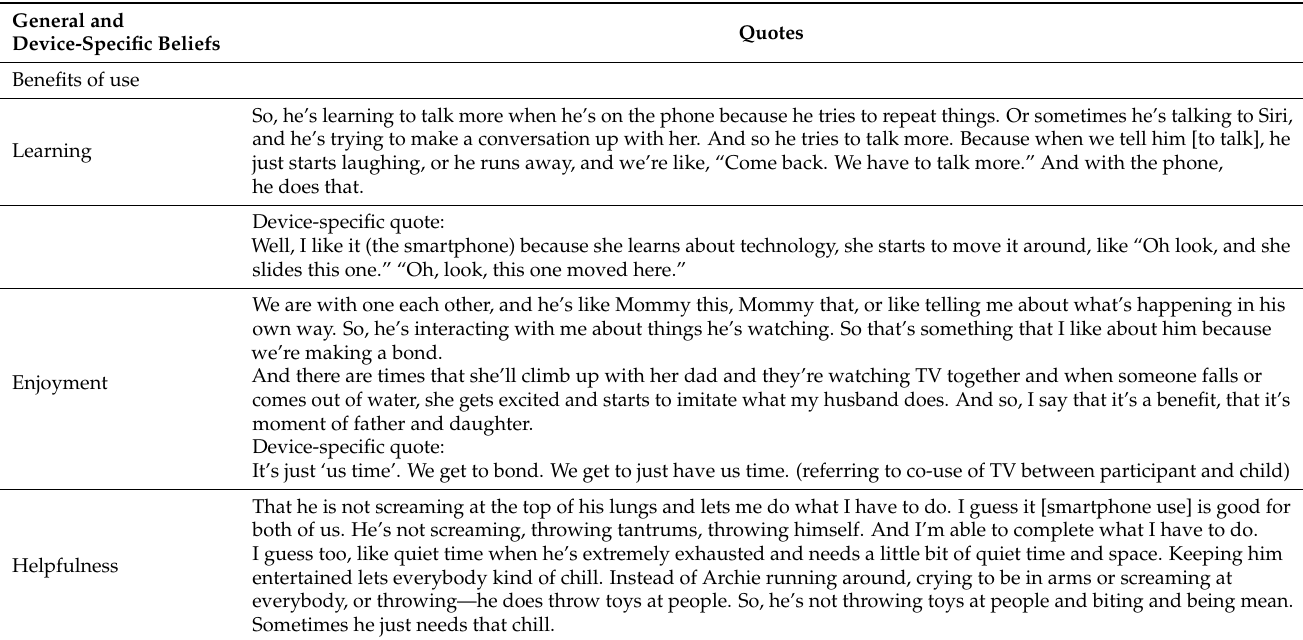
Table 2. Screen-related Beliefs: Representative Quotes from Interviews with Mexican American Parents of Toddlers ( n = 32)